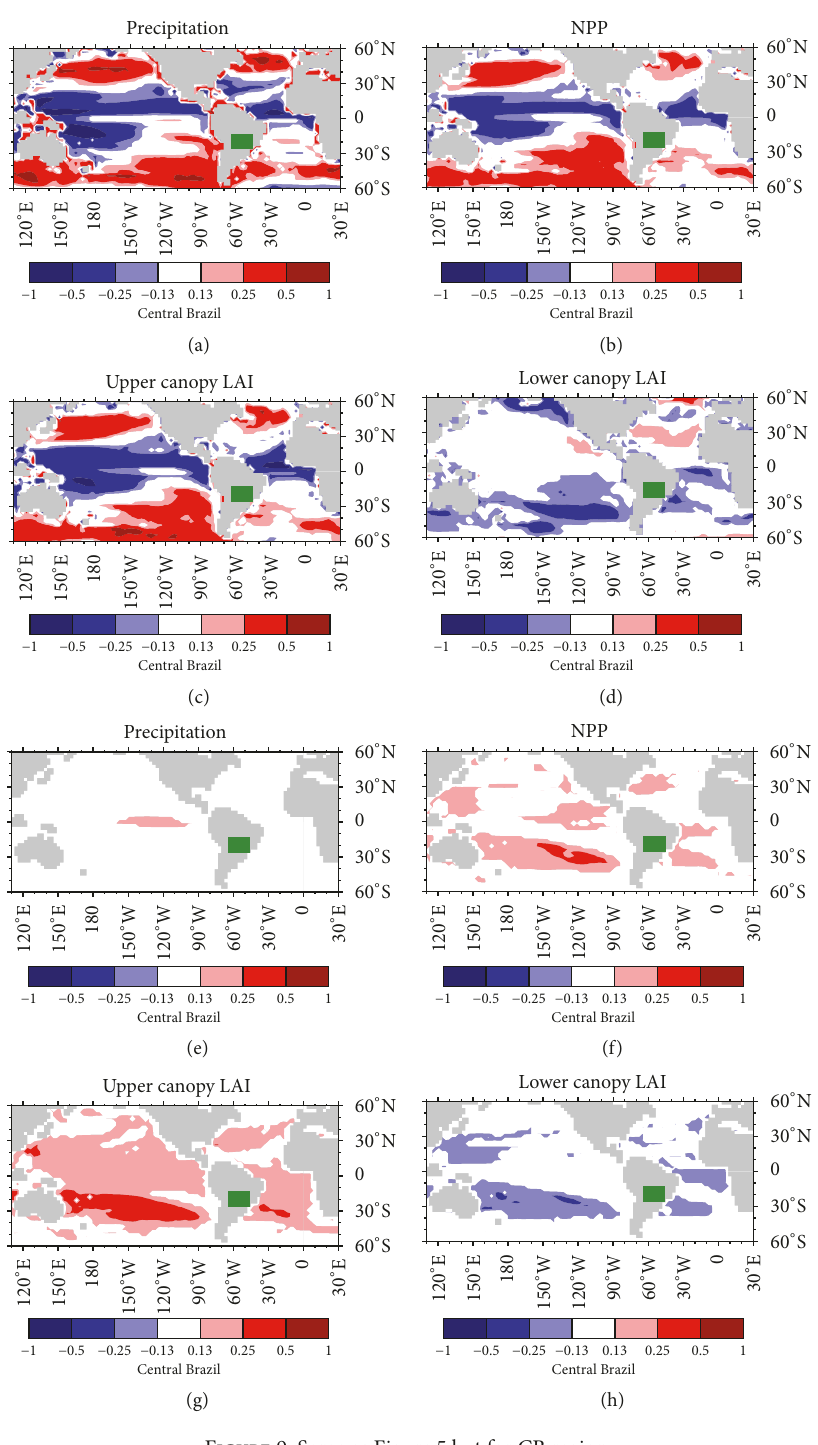
Figure 9: Same as Figure 5 but for CB